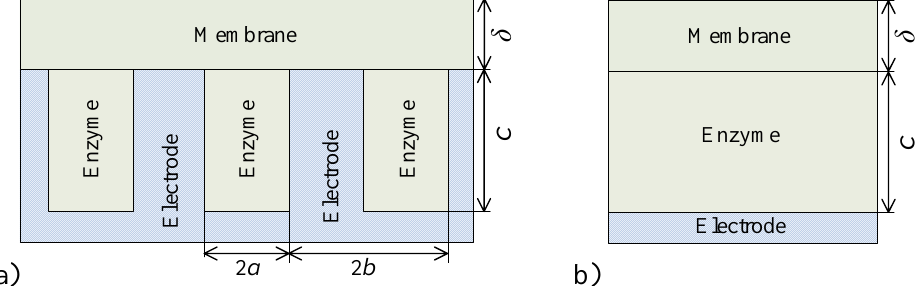
Figure 1 . A principal structure of a plate − gap biosensor (a) and the corresponding flat one (b), both with the outer membrane. The figure is not to